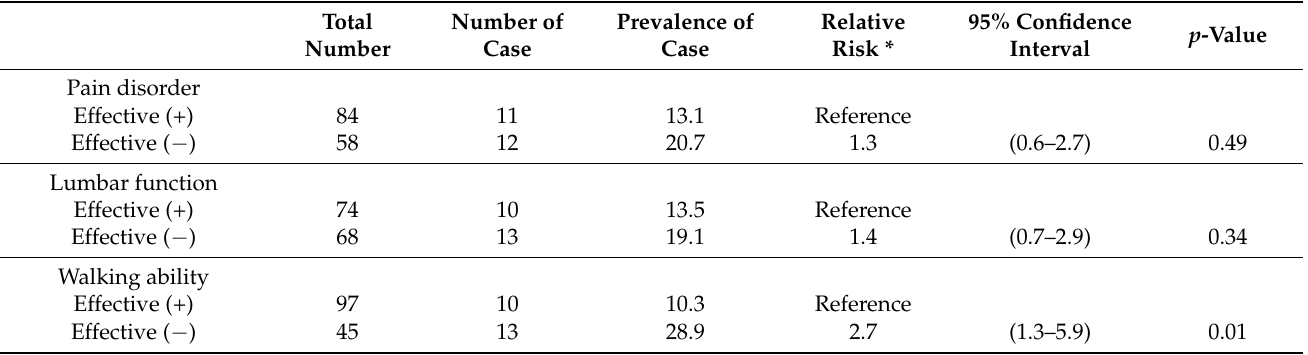
Figure 2. ( A ) Comparison of the preoperative and 6-month and 1-year postoperative number of LSCS medications in the participants. The proportion of patients taking from 3 to 5 LSCS medications gradually decreased after surgery. Conversely, the proportion of patients taking no LSCS medications gradually increased after surgery. There was a significant decrease in the proportion of patients taking LSCS medications, both 6 months and 1 year after surgery. ( B ) Distribution of changes in the number of LSCS medications 6 months (left panel) and 1 year after surgery (right panel). Table 4. Poisson regression model for increase of LSCS medications after 1 year of